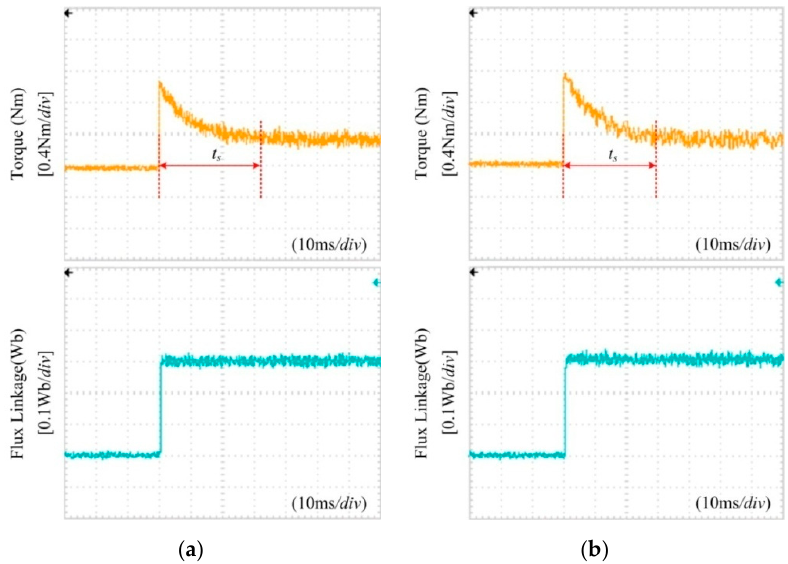
Figure 9. The torque and flux trajectory with the speed changes from 0 rpm to 100 rpm when using: ( a ) FS-DTC; ( b ) FS-DDTC.